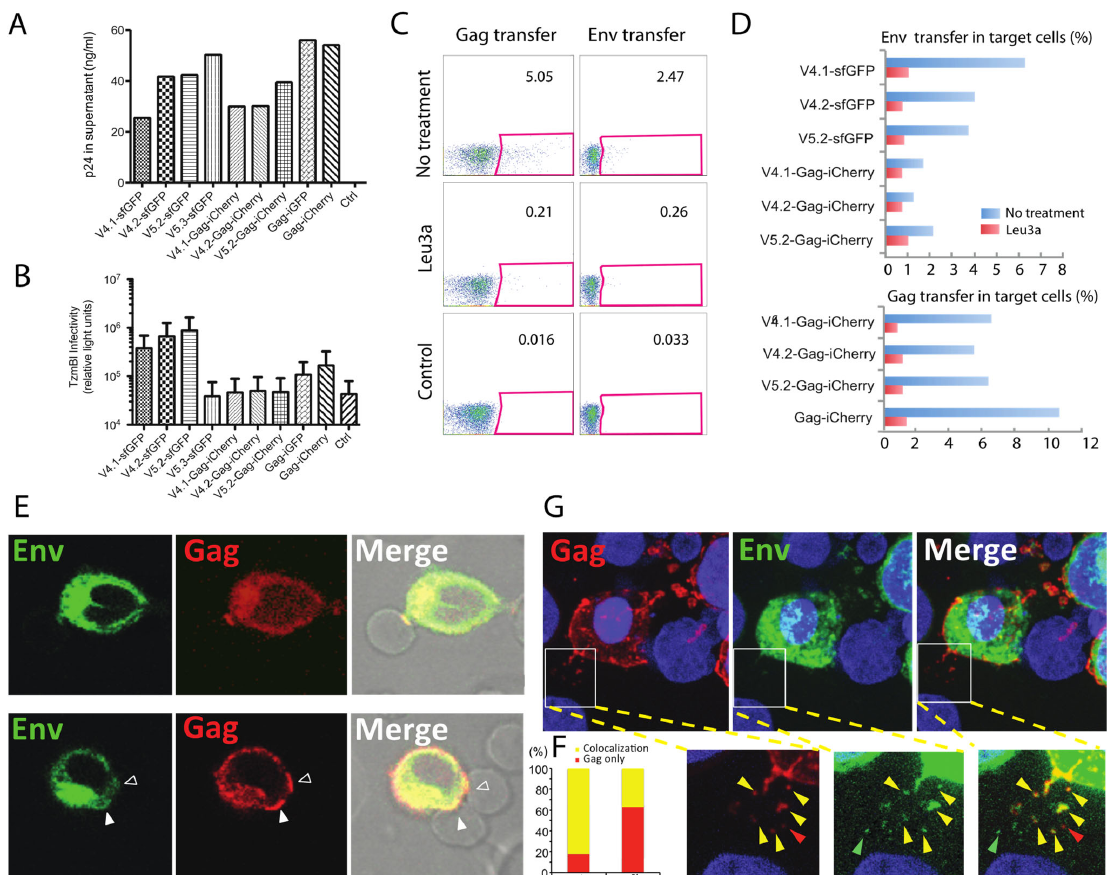
Figure 3. Cell ‐ to ‐ cell HIV ‐ 1 transfer assays using dual fluorescent construct of V4/V5 ‐ Gag ‐ iCherry. ( A ) Dual fluorescent HIV ‐ 1 constructs produce viral particles in 293 T cells as measured by p24 ELISA. Representative example of several transfection experiments is shown. “Ctrl” represents mock ‐ transfected supernatants. In previous studies, HIV ‐ Gag ‐ iGFP and HIV Gag ‐ iCherry produce ~50% WT HIV NL4 ‐ 3 levels of p24 [46]. ( B ) Infectivity of these dual fluorescent HIV ‐ 1 constructs using Tzm ‐ bl assay shows infectivity of single fluorescent Env constructs and lack of infectivity of viruses carrying chimeric Gag ‐ iCherry or Gag ‐ iGFP. ( C ) Dual fluorescent constructs HIV ‐ 1 V4.2 ‐ Gag ‐ iCherry participates in cell ‐ to ‐ cell transfer of HIV from Jurkat to primary CD4 T cells. Flow cytometry measures transfer of Gag ‐ iCherry and Env V4.2 ‐ sfGFP signal following cell–cell co ‐ culture, and the transfer is sensitive to CD4 antibody leu3a. Control condition shows background fluorescence of target cells alone. ( D ) Cell ‐ to ‐ cell HIV ‐ 1 transfer of Gag and Env measured with indicated fluorescent HIV ‐ 1 constructs. ( E ) HIV ‐ 1 VS between HIV V4.2 ‐ Gag ‐ iCherry transfected Jurkat cells and primary CD4 T cells. Primary CD4 cells from healthy human peripheral blood were co ‐ cultured with transfected donor cells for 3 h. Upper panel: A synaptic button with both Gag and Env is shown between a donor Jurkat cell and a target cell. Lower panel: one donor cell nucleofected with V4.2 ‐ Gag ‐ iCherry formed two VSs: the lower synapse shows both Env and Gag concentrated at the cell–cell contact site, while the upper synapse shows Gag accumulation without Env accumulation. ( F ) Analysis of Env and Gag colocalization at virological synapses. Samples fixed at 1 h post co ‐ culture and 3 h post co ‐ culture were compared. VSs, n = 17 at 1 h and n = 24 at 3 h, counted from 6 fields of view were defined by Gag at the site of cell–cell contact and categorized by reviewers blinded to time point, to enumerate whether Env was colocalized at cell–cell contact site (yellow) or whether Gag was present without Env (red). ( G ) Transfer of both Gag and Env into target cells. Co ‐ cultured cells were fixed and observed by confocal microscopy. Inset shows partial colocalization of transferred Gag and Env. Green, red and yellow arrowheads show Env only, Gag only transfer or co ‐ transfer of both Gag and Env. Bar: 5 μ m.